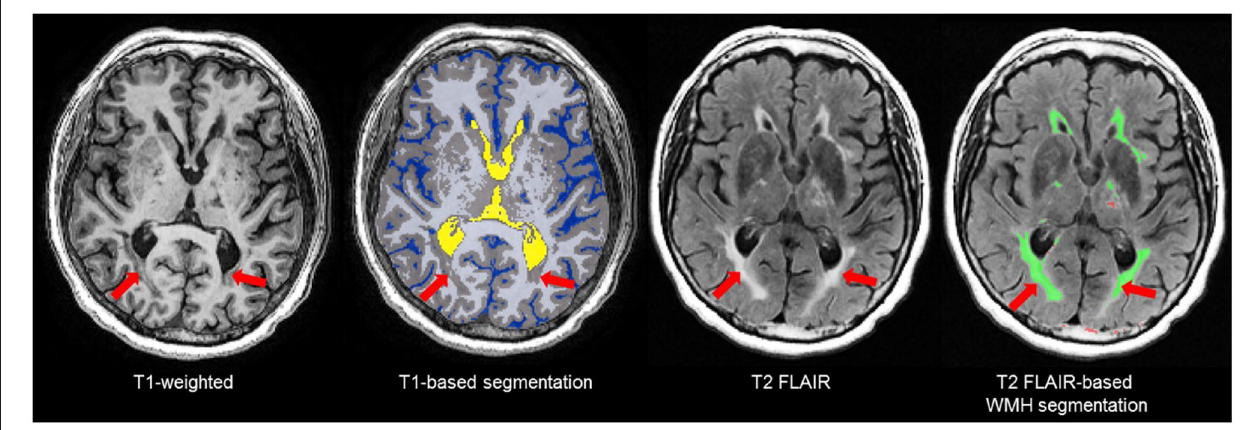
FIGURE 5 | Due to relative intensities on different MRI sequences, WMH (red arrows) on T2 FLAIR are not hyperintense (bright) on T1-weighted images and tend to appear as GM (gray) or CSF (blue) intensity on T1. Thus, T1-based segmentations tend to inflate the GM and CSF volumes in patients with stroke and cerebral small vessel disease. To account for this, ONDRI’s imaging pipeline integrates an additional T2/FLAIR-based WMH segmentation to correct for this misclassification error (42) to produce a normal appearing WM/GM (NAWM/NAGM) volumes.